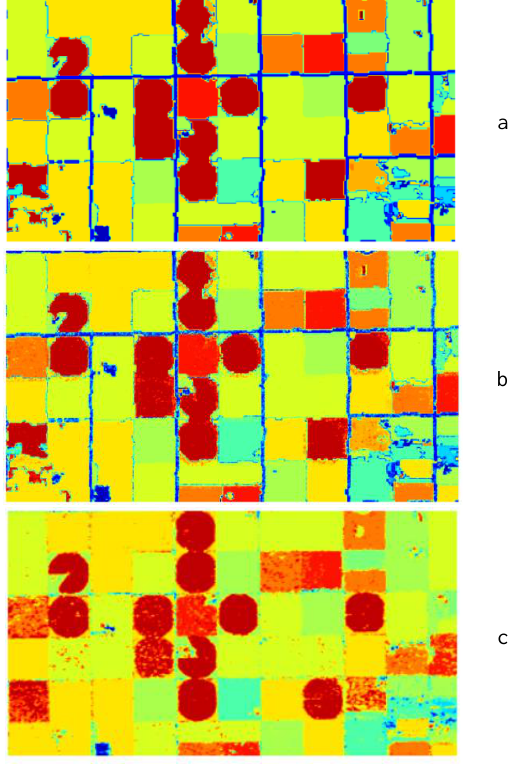
Figure 8. (a) Ground truth, (b) RF predicted map, (c) Cat Boost predicted